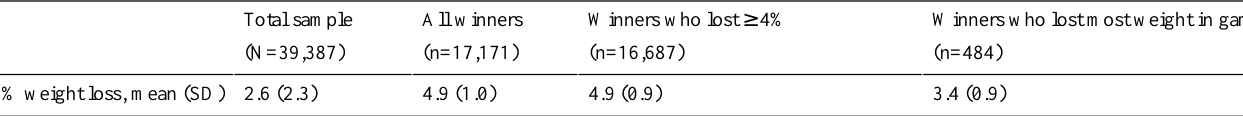
Table 1. Player weight